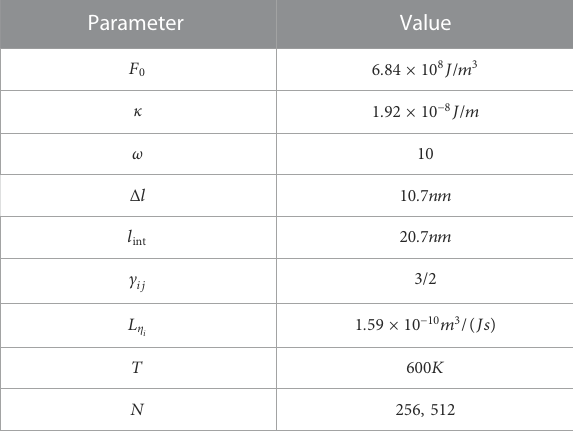
TABLE 1 Parameters used for phase- fi eld simulations.